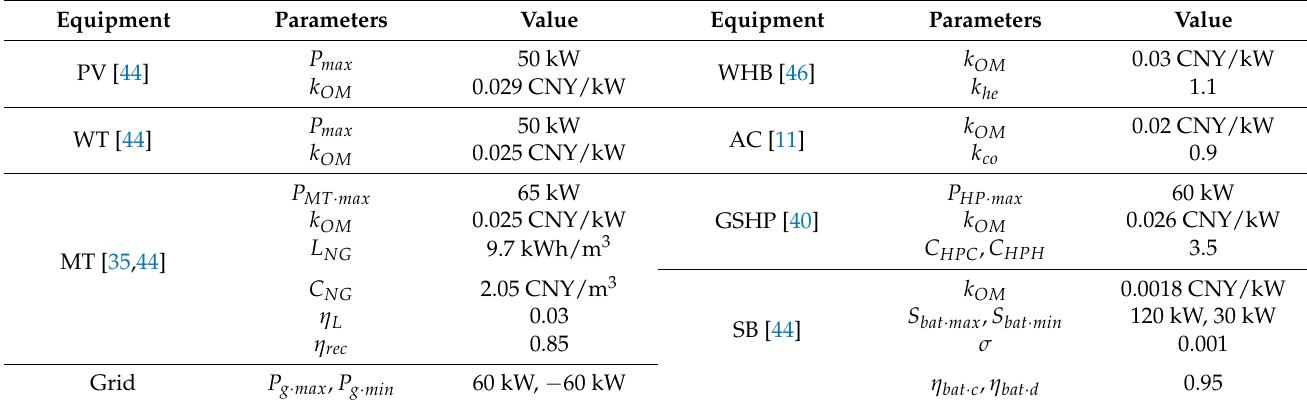
Table 3. The parameters of the equipment in CCHP System.